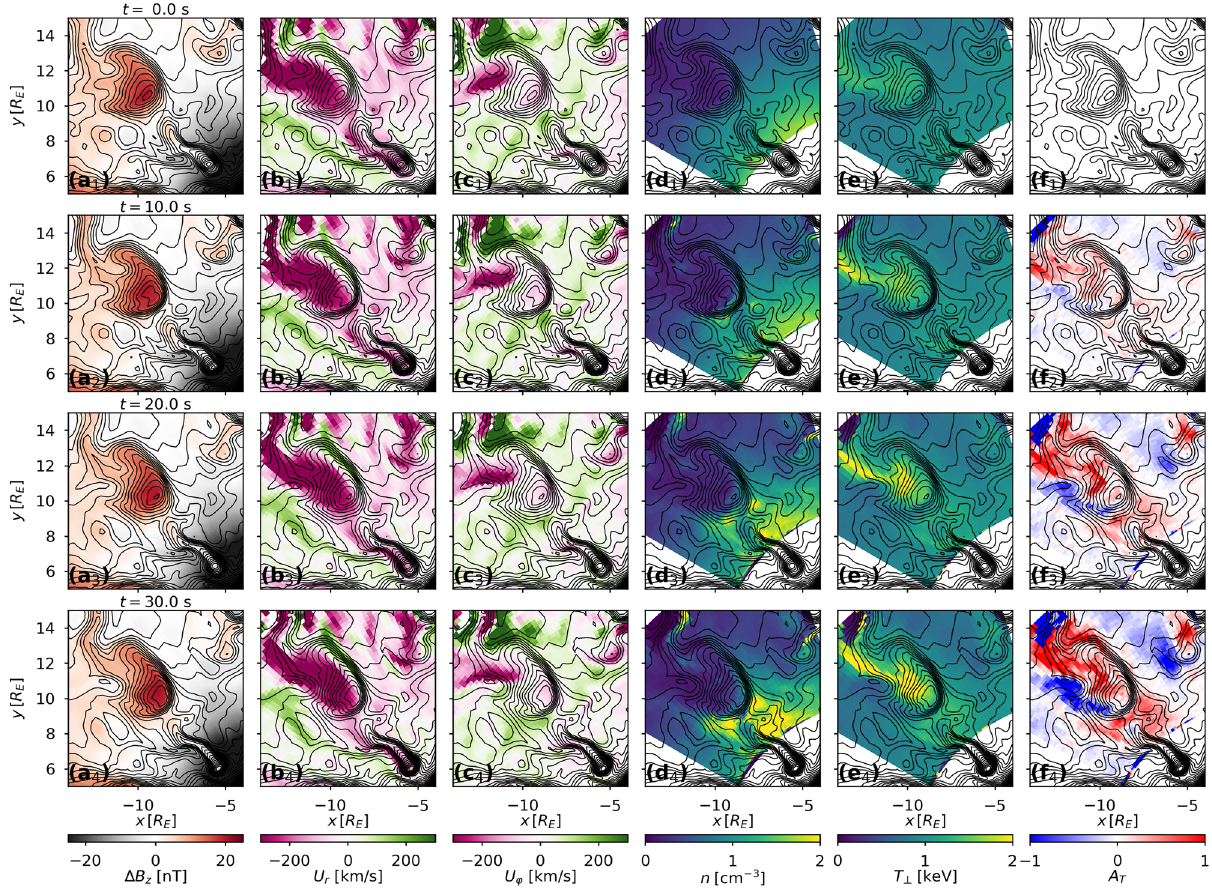
Figure 1. The growth of interchanging regions of parallel and perpendicular temperature anisotropies in electron distributions around a dipolarization flow in MHD and test-particle simulations. Electron PSD at t 0 were initialized with T and n from MHD simulations renormalized to a kappa distribution with κ = 4 . Panels ( a ): external magnetic field, (cid:31) B z ; panels ( b ) and ( c ): the radial, U r and the azimuthal U ϕ and T i / T e = components of the total equatorial drift velocity of 15 keV electrons; panels ( d ) and ( e ) the number density, n , and perpendicular temperature T of electrons in the test-particle simulations; panels ( f ): electron temperature ⊥ anisotropy, A T . Negative (positive) values of A T correspond to temperature anisotropies parallel (perpendicular) to the ambient magnetic field direction. The contours of constant total magnetic field intensity are shown with black lines in all panels of the figure.